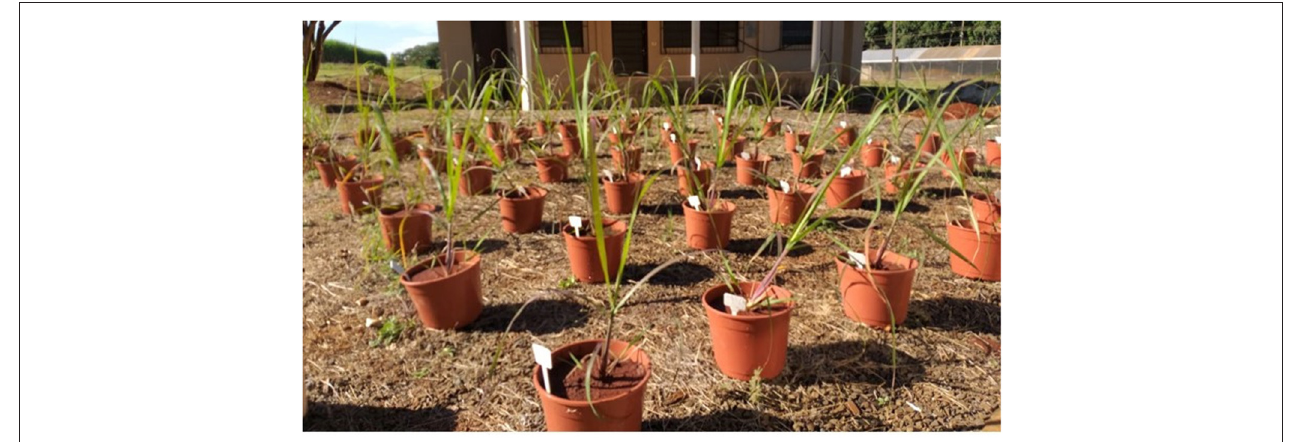
FIGURE 1 | Experimental trial showing sugarcane in pots.